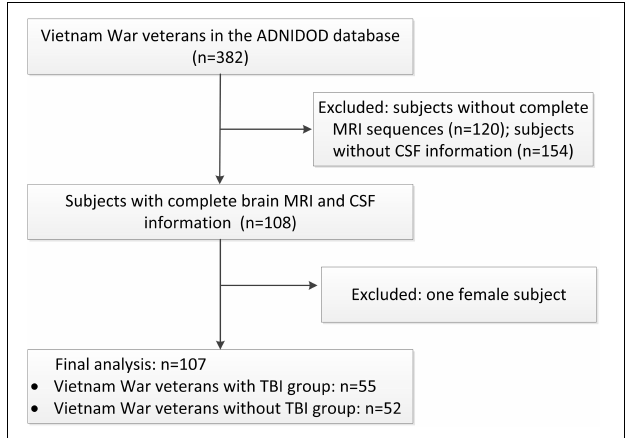
FIGURE 1 | Participants recruitment flow chart.